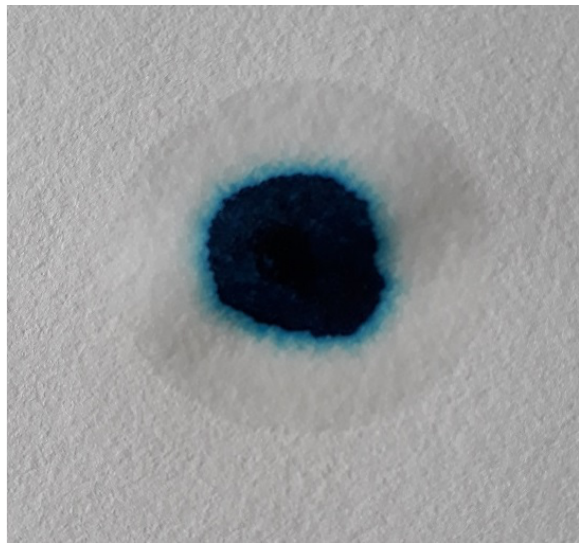
Figure 3. A result of methylene blue test.